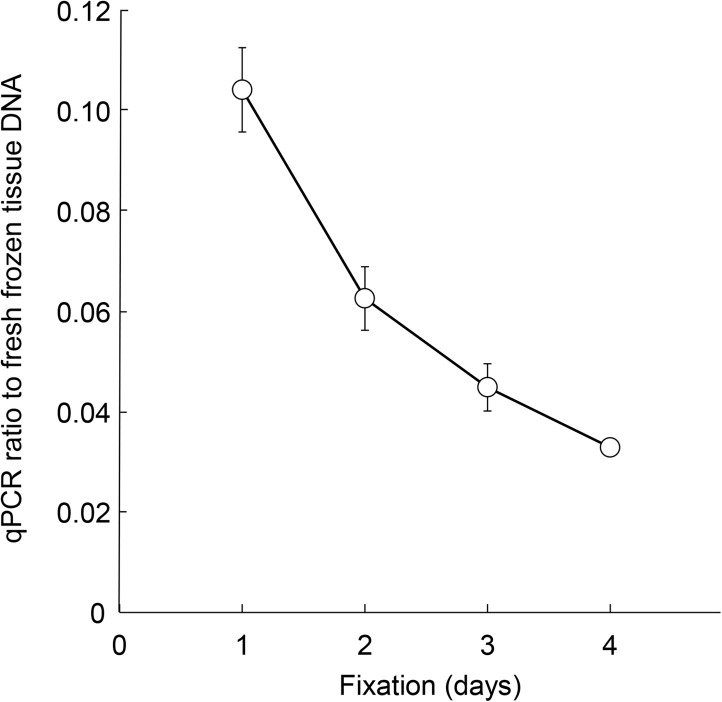
FFPE DNA quality is dependent on the formalin fixation duration.Three sets of 5 matched samples containing fresh-frozen tissue DNA and 4 FFPE (1-, 2-, 3- and 4-day fixation) DNA samples were prepared from 3 rat liver specimens (r1, r2, r3) and examined for DNA quality. The data are shown as averages (circles) with standard deviations (bars).